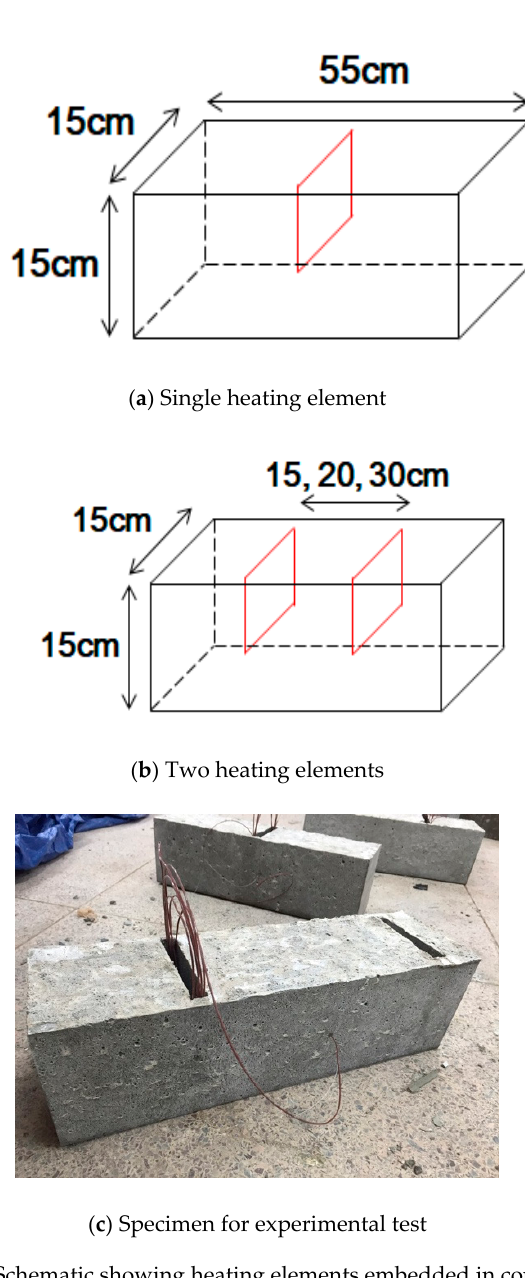
Figure 2. Schematic showing heating elements embedded in concrete beam.